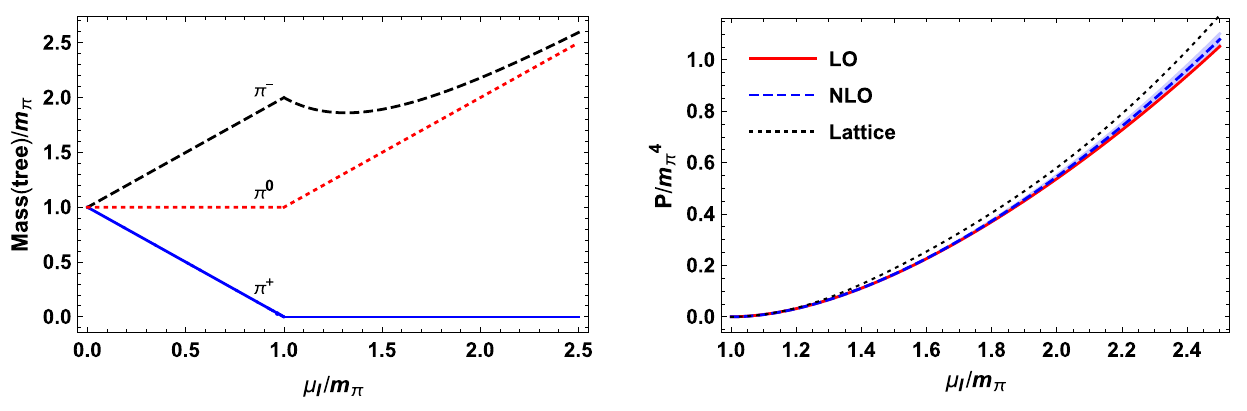
Fig. 2 Tree-level masses normalized to the pion mass in the vacuum as a function of isospin chemical potential normalized by the pion mass in the vacuum